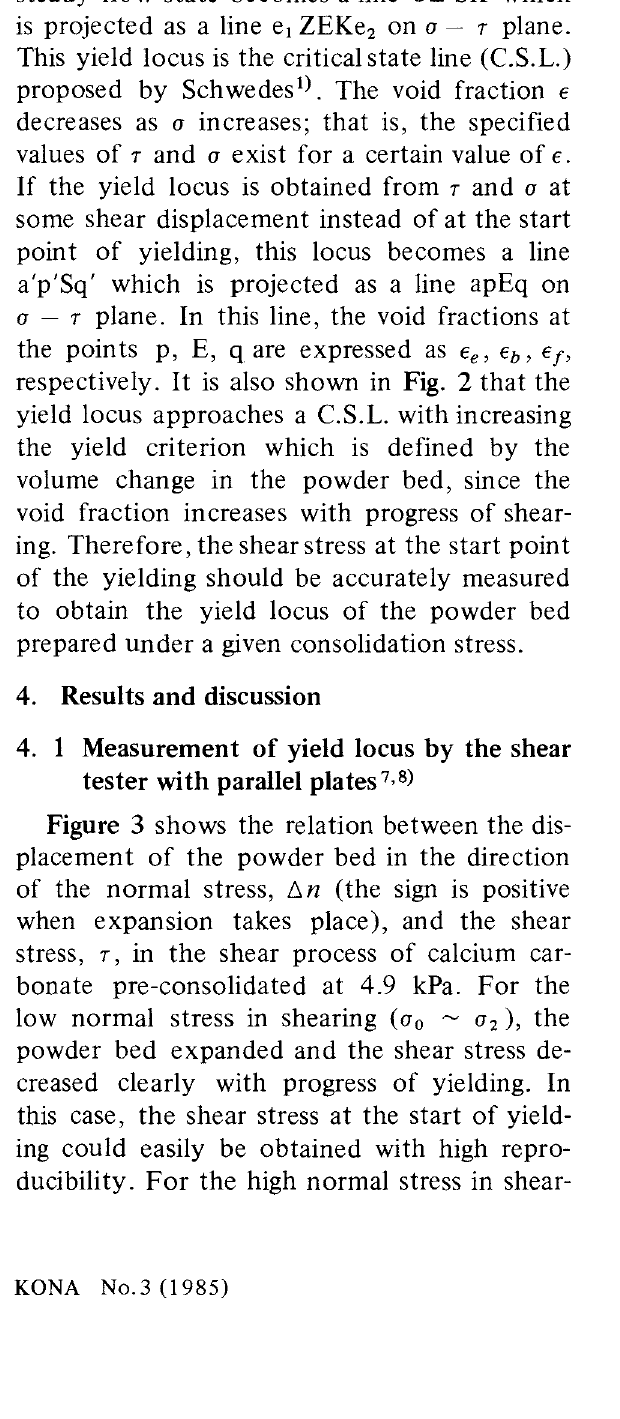
Shear stress r [kPa] Fig. 3 Shear process diagram